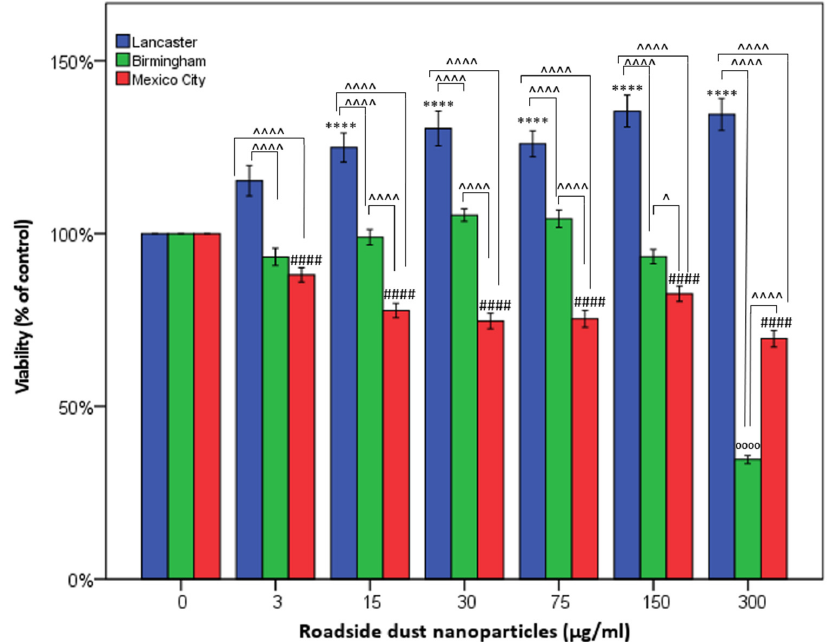
Figure 3. Cytotoxicity of <220 nm-sized road-deposited dust particles (UF-RDPs) on Calu-3 cells. Calu-3 cells were exposed to UF-RDPs (0–300 µg/mL) from Lancaster and Birmingham (UK) and Mexico City (Mexico) for 24 h and subjected to an MTS assay, which reflects cell viability. A one-way ANOVA with Dunnett’s post hoc was conducted, comparing treated cells to the untreated control (* Lancaster, ₀ Birmingham, # Mexico City) and two-way ANOVA with Bonferroni correction to compare the impacts of the UF-RDPs from the three different locations (^). Statistical significance levels used are: *, p ≤ 0.05; ****, p ≤ 0.0001 where * may be substituted for ^, # or ₀ depending on the city or comparison being made.